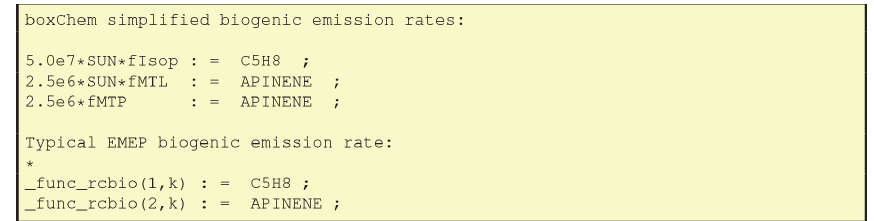
Figure 7. Biogenic emissions lines from input files used in GenIn_Reactions.txt , for either EMEP or boxChem